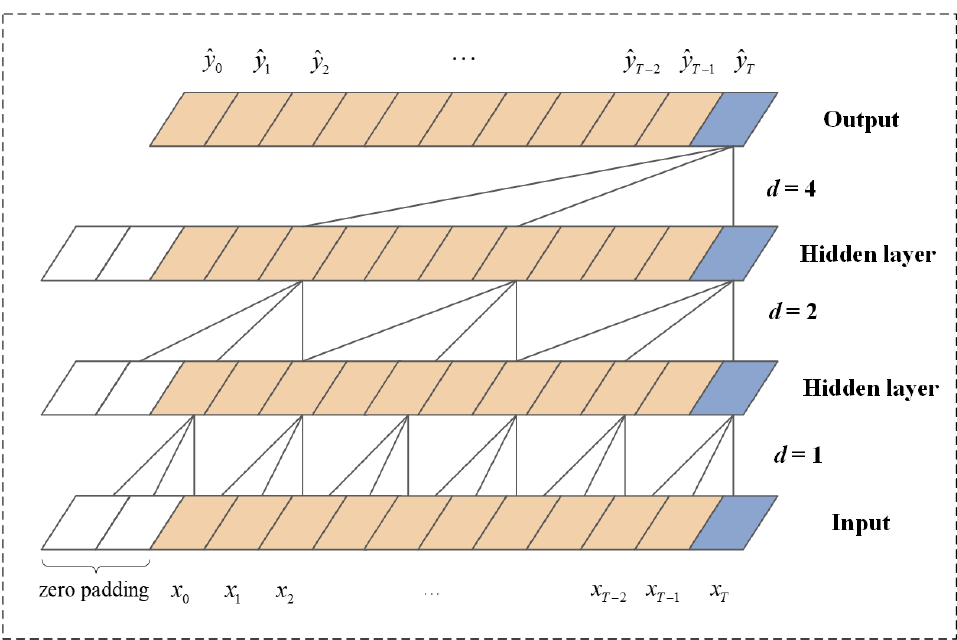
Figure 5. Schematic of TCN dilated causal convolution.